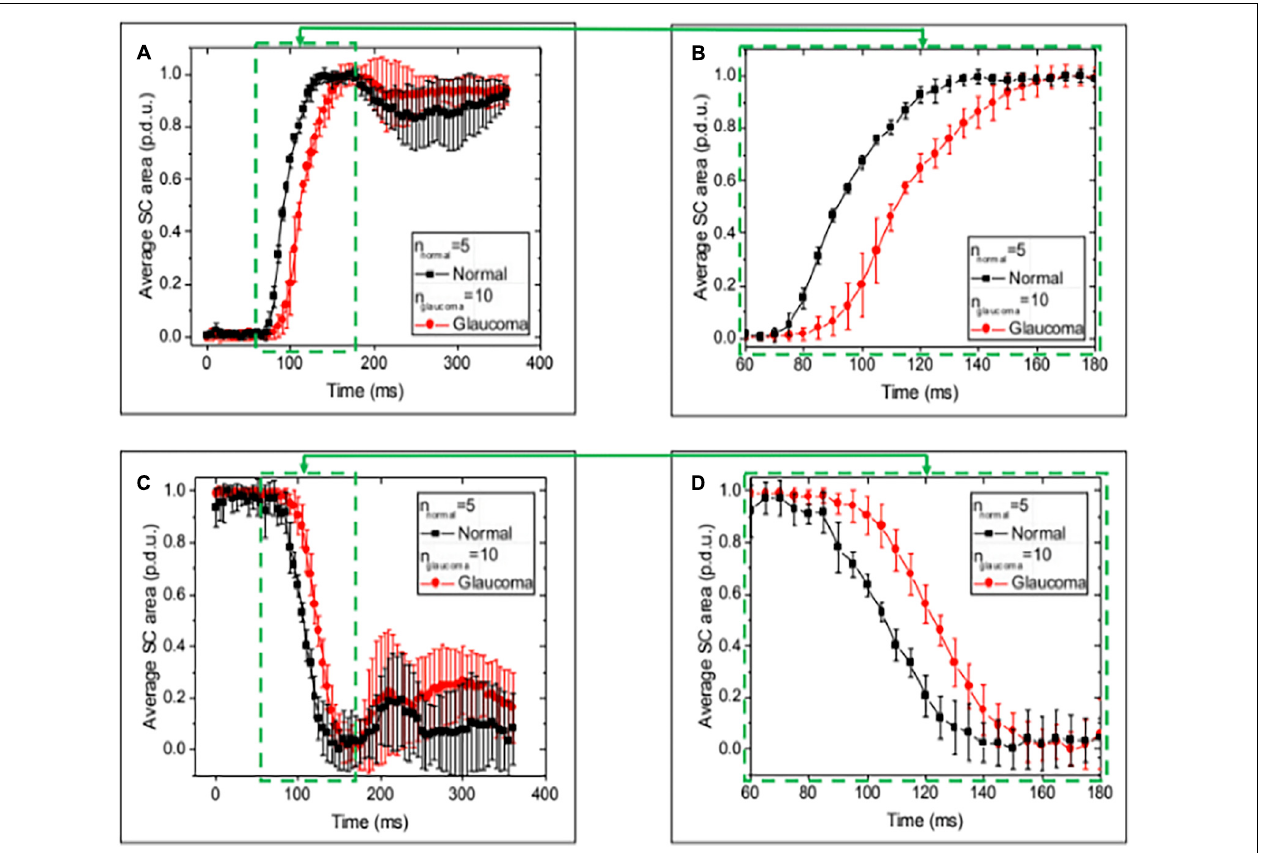
FIGURE 8 | Normal and glaucoma eye responses to Schlemm’s canal pressure changes. Images (A,C) show normalized SC cross-sectional area vs. time over a 400 ms time interval while imaging at 5-s intervals during the 0–30 and 30–0 mm Hg changes in reservoir pressures. Data are the mean and SEM for normal and glaucoma eyes. (B,D) Are an enlarged view of areas (A,C) . The mean Schlemm’s canal area change occurred more rapidly in the normal than the glaucoma eyes at multiple time intervals. The total time to reach the peak or trough of motion was ≤ 200 ms. Oscillatory behavior remained a feature of the aggregated measurements at the end of both the rising and falling intervals. The mean time to a new peak or trough was ≤ 200 ms. Supplementary Table 2 provides a summary of baseline and final areas. MANOVA (cid:49) for Normal vs. Glaucoma curves ( p <